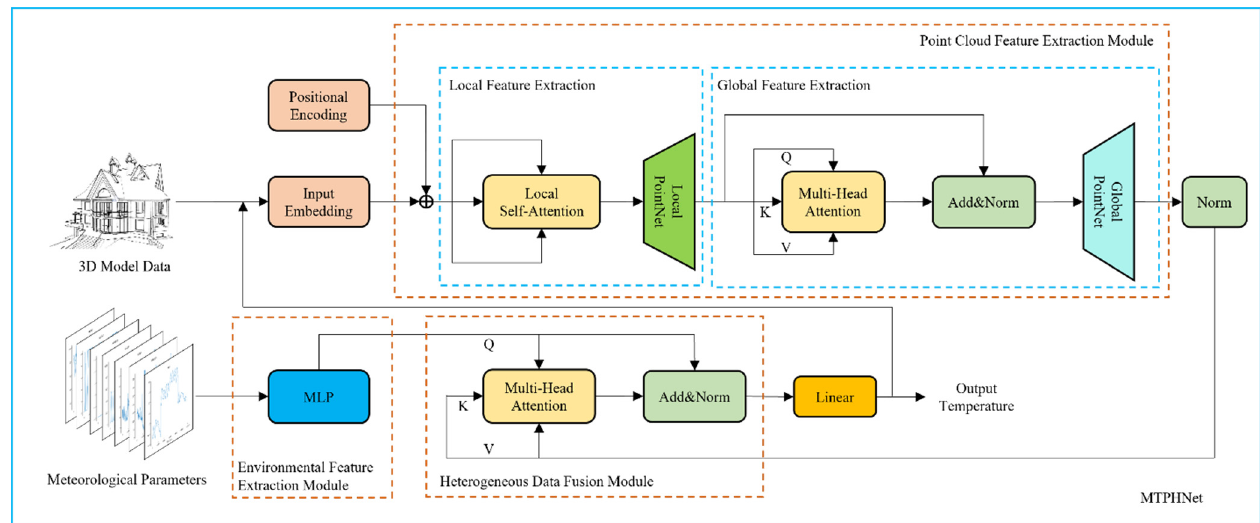
Figure 2. Structure of the multivariate temperature field prediction network based on heterogeneous data (MTPHNet). MLP: Multilayer perceptron.